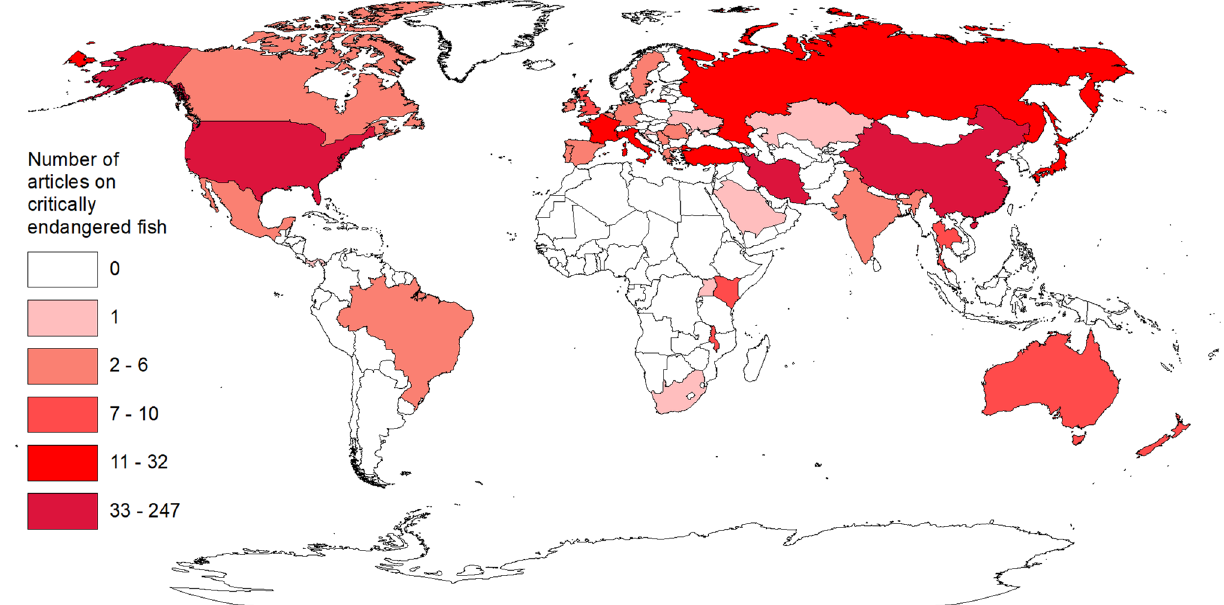
Figure 4. Number of articles on critically endangered fishes by country. Data are from 721 articles where any author on the article had a location that matched the geographical range of the critically endangered fish in the article title. Figure was created using ArcMap (version 10.7.1 & URL: https:// www. esri. com/ en- us/ home) and the outline of countries was acquired from the ArcGIS Hub (URL: https:// hub. arcgis. com/ datas ets/ a21fd